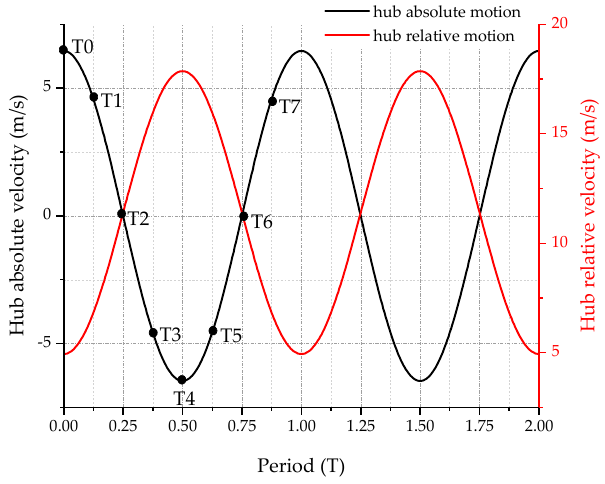
Figure 13. Combined motion analysis under case 14 ( 𝐴 (cid:3017) = 4 ° , 𝐴 (cid:3020) = 4 m , 𝑓 (cid:3020) = 0.1 Hz ). Table 6. Cases of same-phase combined motion.